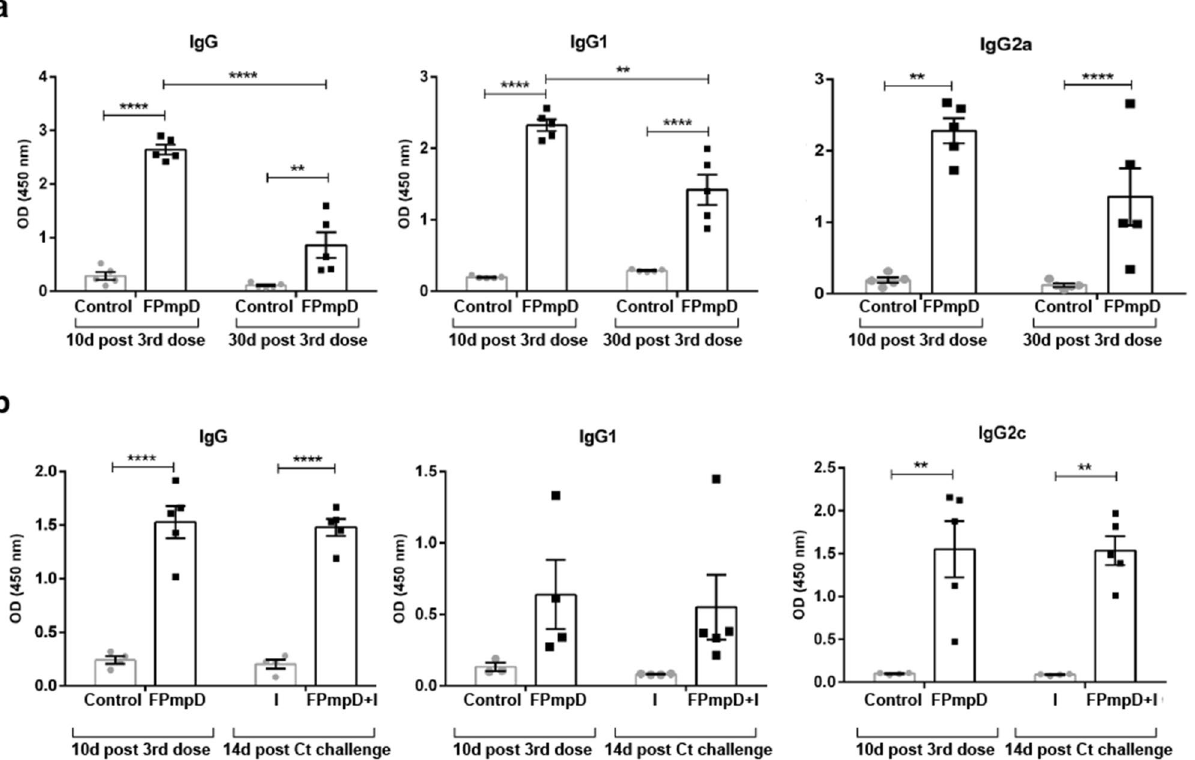
Figure 8. Evaluation of the humoral immune response over time. ( a ) Anti-PmpD IgG, IgG1, IgG2a antibody levels in sera obtained at the indicated times from non-vaccinated (Control) or FPmpD-vaccinated (FPmpD) BALB/c mice. ( b ) Anti-PmpD IgG, IgG1, IgG2c antibody levels of sera obtained ten days post last dose from non-vaccinated (Control) and FPmpD-vaccinated (FPmpD) C57BL/6 mice; and in sera collected 14 days